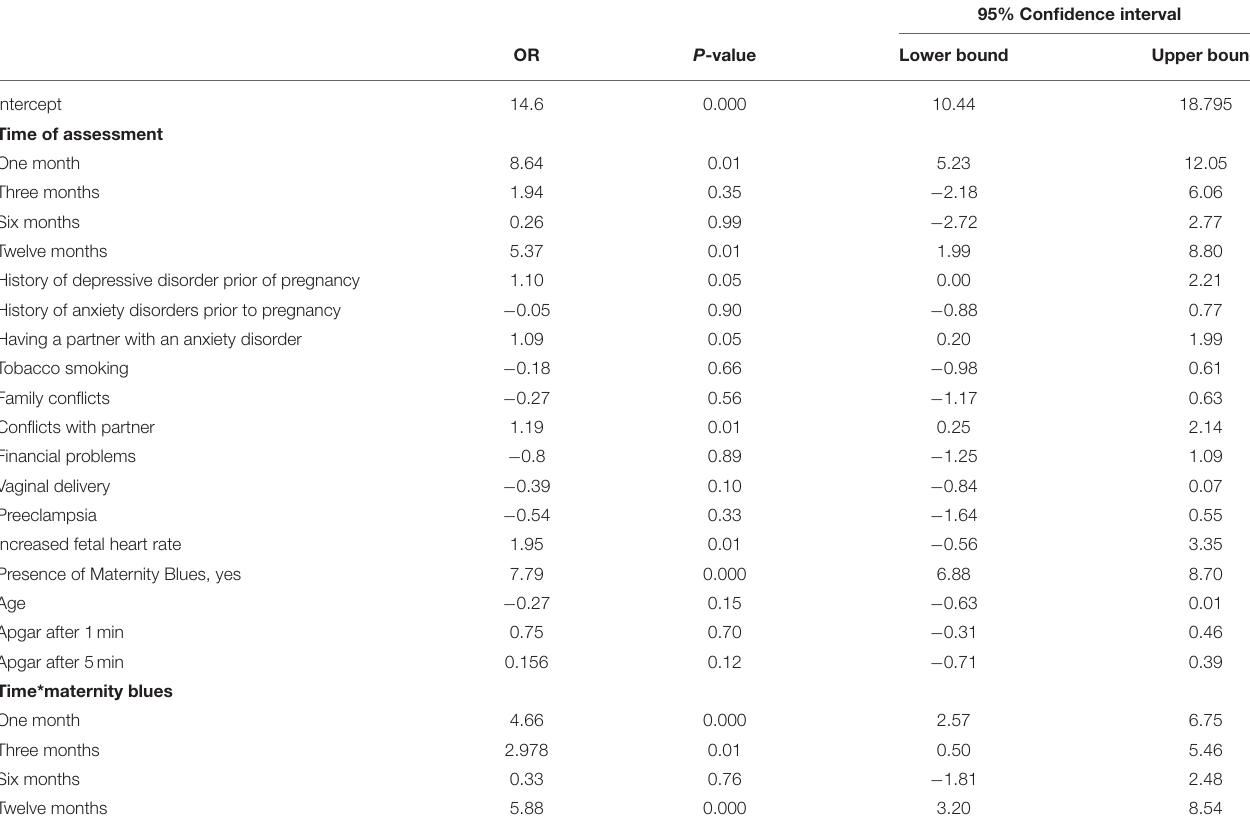
TABLE 3 | Predictors of PDD at follow-ups (dependent variable: EPDS main